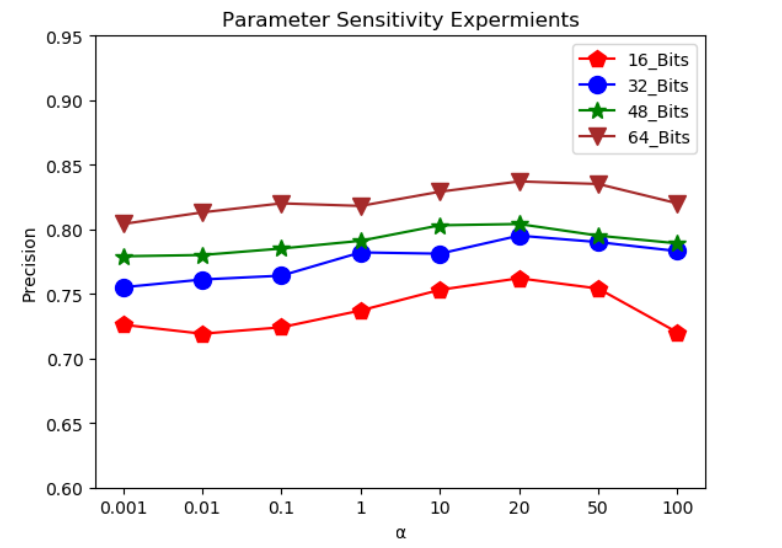
Figure 5. Parameter sensitivity curves of ADMTH to α